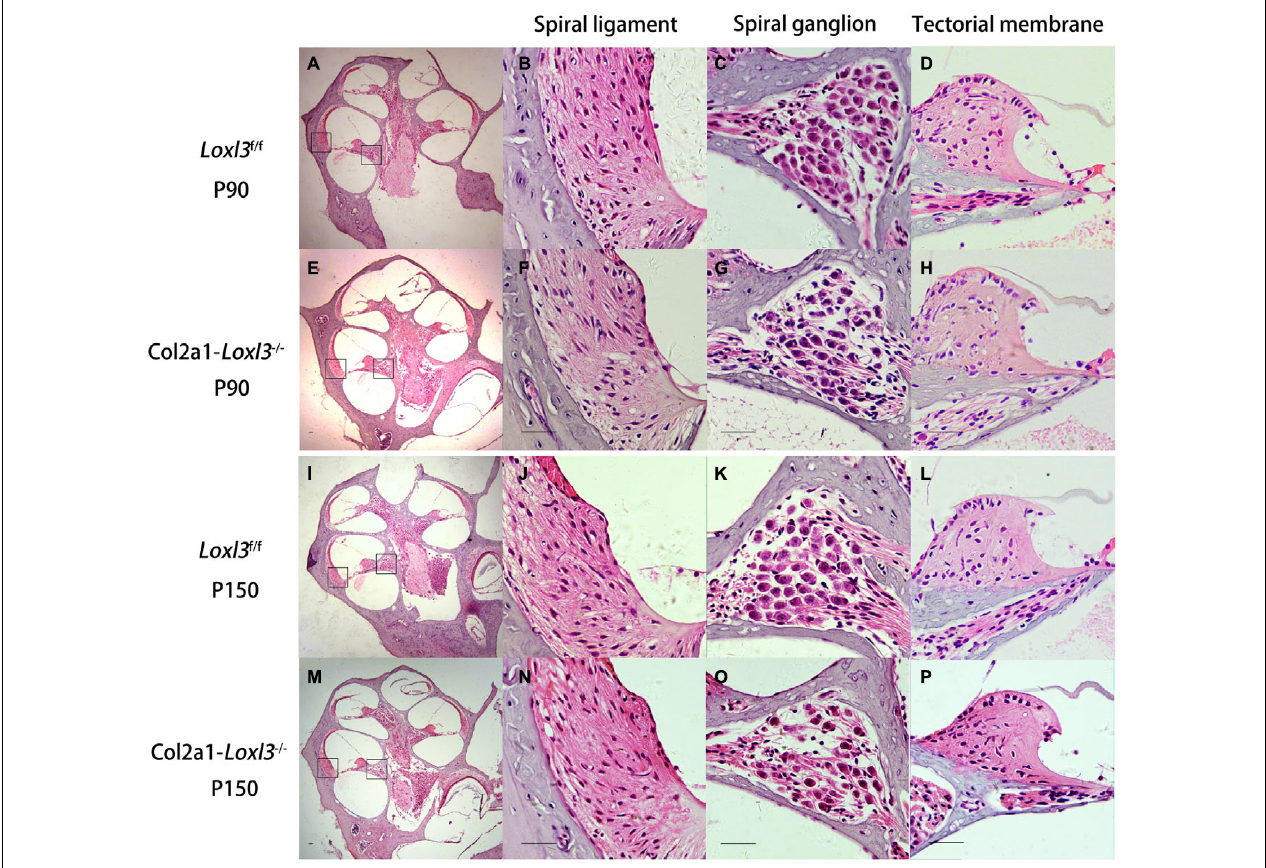
FIGURE 5 | Normal cochlear morphology and progressive degeneration of spiral ganglion neurons (SGNs) in Col2a1–Loxl3 − / − mice. (A–H) Hematoxylin and eosin (H&E) staining of sections of Loxl3 f / f and Col2a1–Loxl3 − / − mice at P90. No significant abnormality was observed in the spiral ligament, where Loxl3 was conditionally inactivated. (I–P) Hematoxylin and eosin staining of sections of Loxl3 f / f and Col2a1–Loxl3 − / − mice at P150. The progressive degeneration of the SGNs appeared in the cochlea basal turn of Col2a1–Loxl3 − / − mice at P150. Scale bars: 200 µ